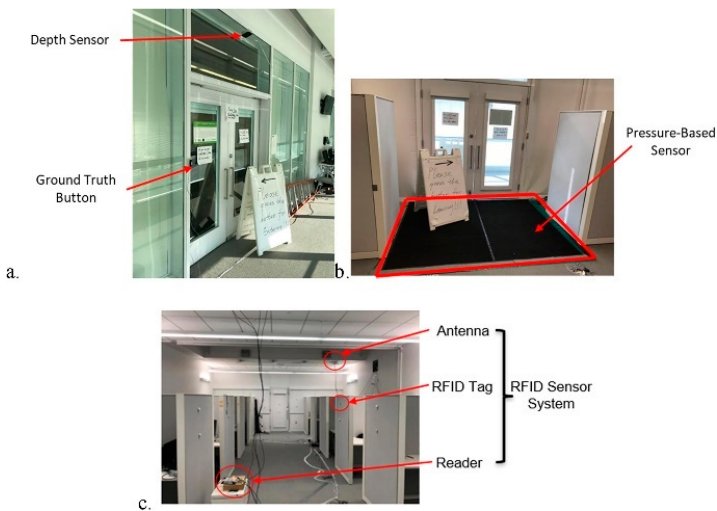
Figure 3. The deployment of the sensors in Ref. [50]. ( a ). depth sensor and ground truth button; ( b ). pressure-based sensor; ( c ). RFID sensor system.